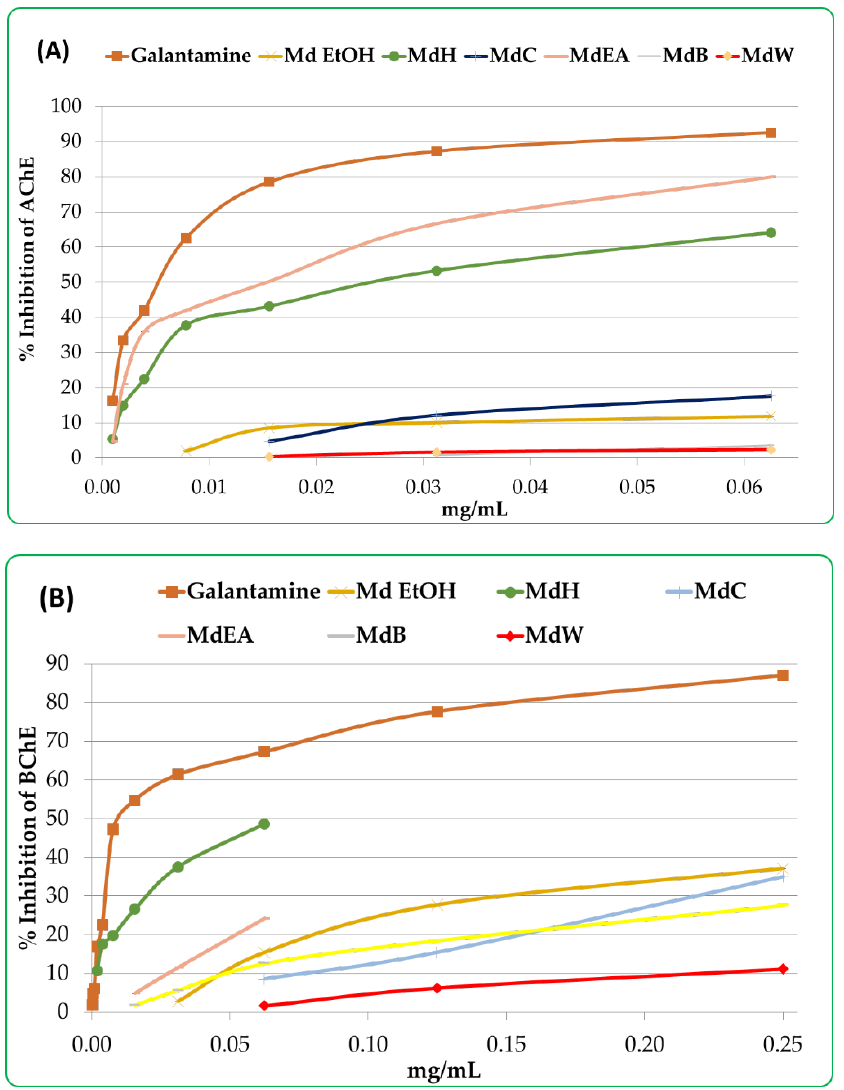
Figure 5. AChE ( A ) and BChE ( B ) inhibition activity of different M. diffusa samples. Samples are galantamine, crude ethanol extract (Md EtOH), n -hexane fraction (MdH), chloroform fraction (MdC), ethyl acetate fraction (MdEA), n -butanol fraction (MdB) and water fraction (MdW).